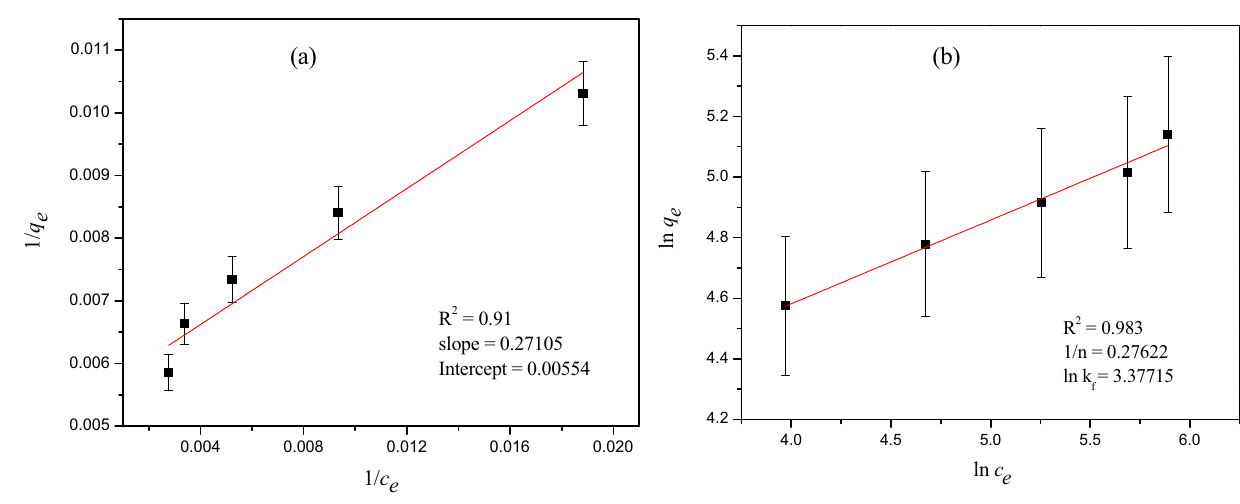
Fig. 7 Adsorption isotherm for the adsorption of Pb (II) by n-CaCO